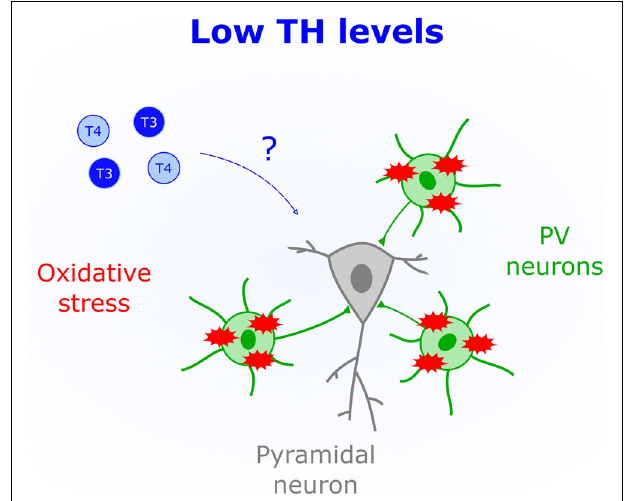
FIGURE 4 | Enhanced cholinergic transmission is characteristic of CPs. An important role of TH (blue) early in life could be to increase the acetylcholine synthesis and